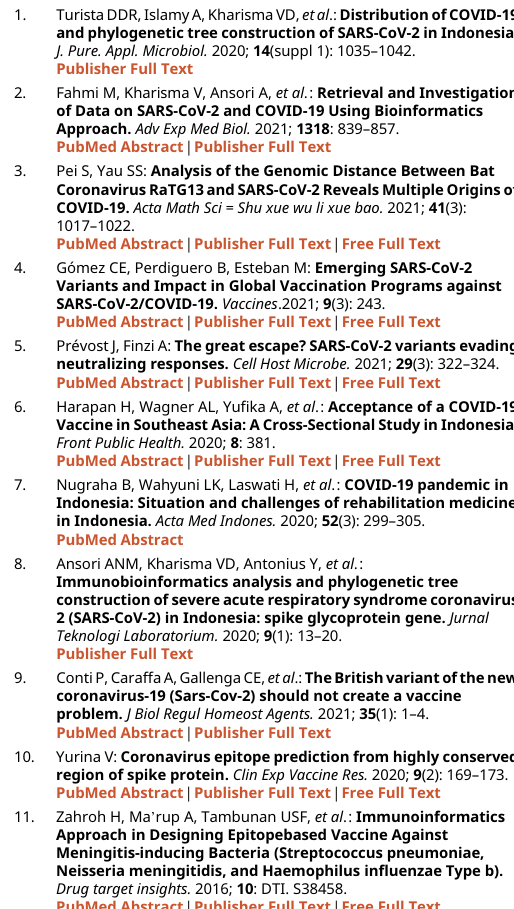
Access to GISAID data requires registration and agreement to GISAID ’ s